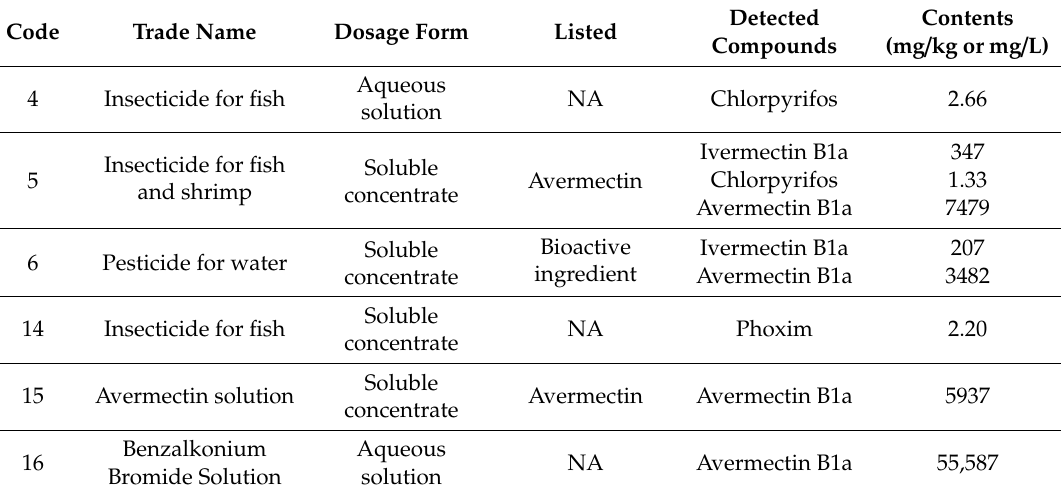
Table 2. Screening results of practical fishery